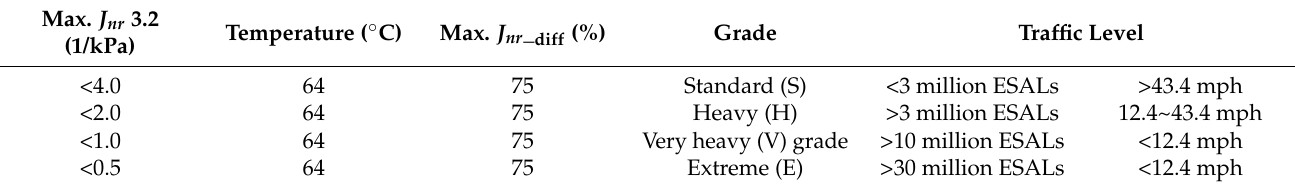
Table 7. Traffic grading according to J nr